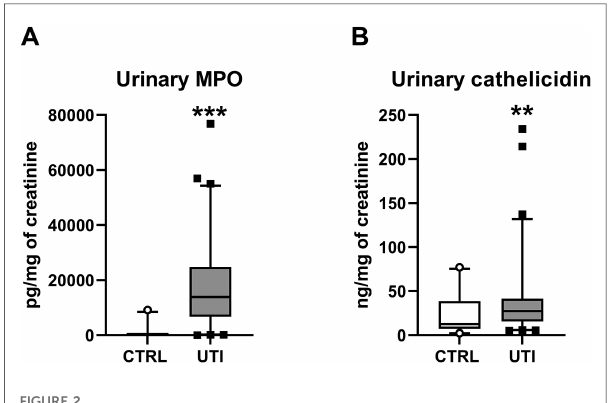
FIGURE 3 Correlation between cathelicidin and myeloperoxidase (MPO) in urine of children with urinary tract infection (UTI). Relations were tested using Spearman ’ s rank correlation test. p values less than 0.05 are considered as statistically signi fi cant.